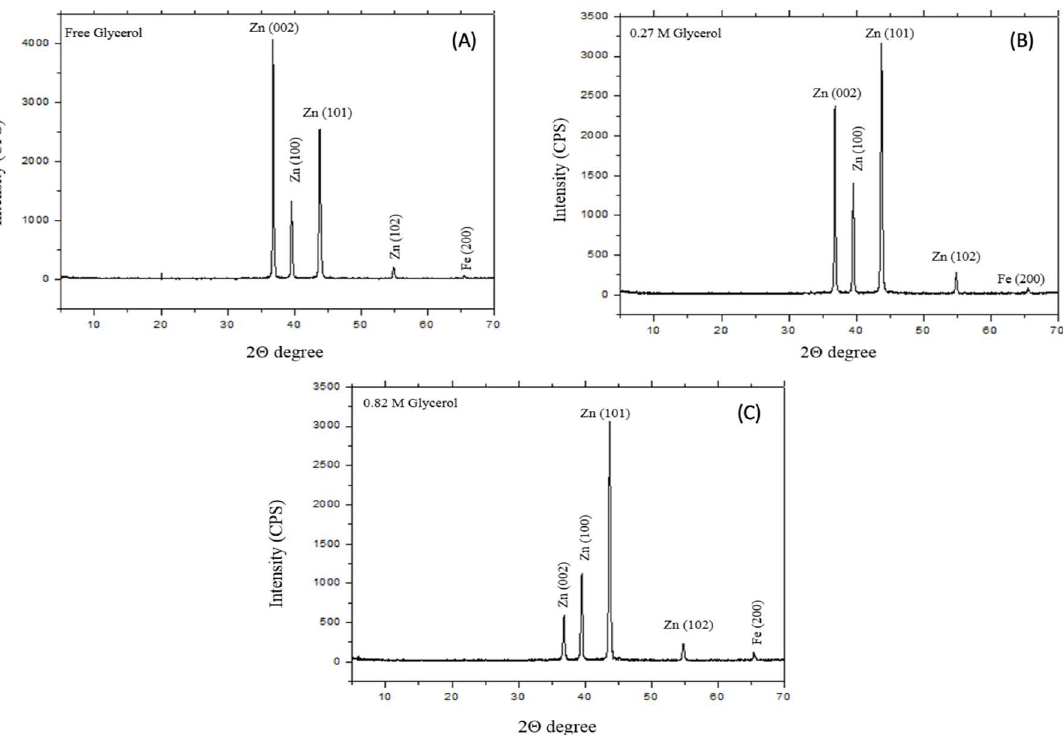
Figure 4. XRD patterns of the coatings obtained (A) without glycerol in the presence of (B) 0.27 M e (C) 0.82 M and in the absence of